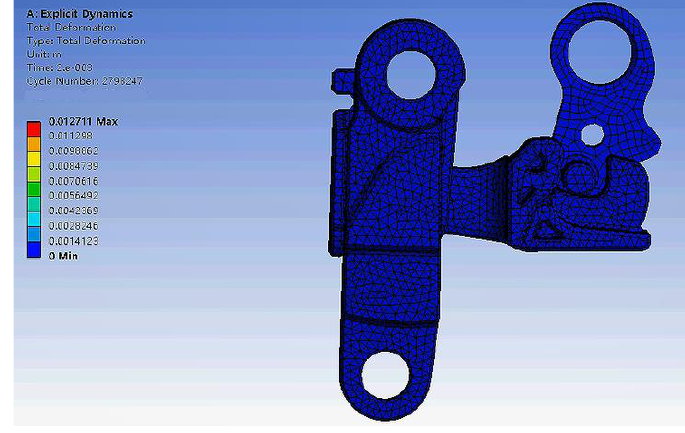
Figure 14. The initial state of the door latch simulation movement.